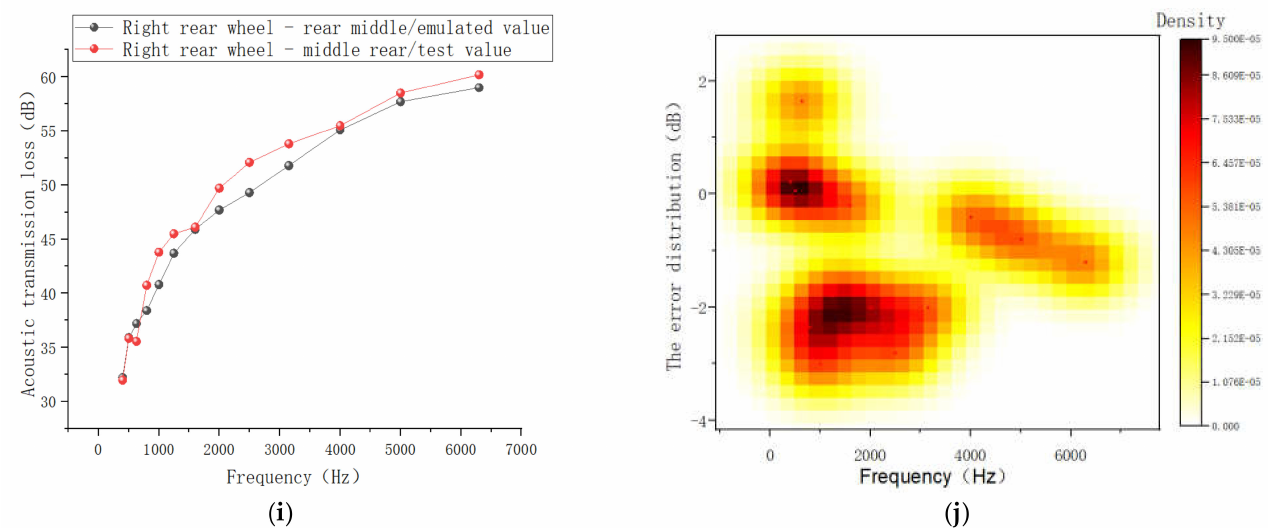
Figure 13. Verification results of cab model. ( a ) Acoustic transmission loss under left front wheel excitation; ( b ) Acoustic transmission loss under left front wheel excitation; ( c ) Acoustic transmission loss under right front wheel excitation; ( d ) Acoustic transmission loss under right front wheel excitation; ( e ) Acoustic transmission loss under engine room excitation; ( f ) Acoustic transmission loss under engine room excitation; ( g ) Acoustic transmission loss under left rear wheel excitation; ( h ) Acoustic transmission loss under left rear wheel excitation; ( i ) Acoustic transmission loss under right rear wheel excitation; ( j ) Error distribution under right rear wheel